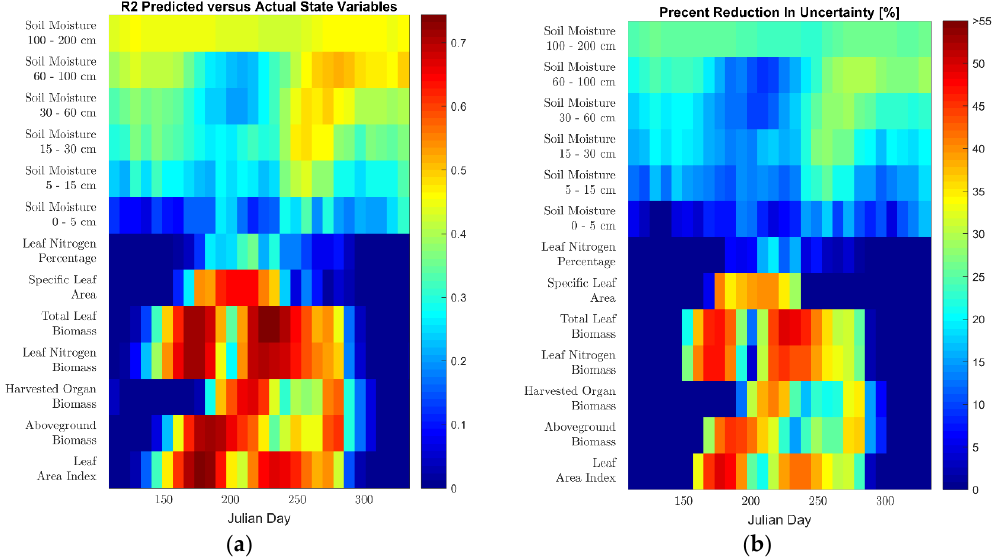
Figure 10. ( a ) CV R 2 and ( b ) CV PRU physical state variable prediction results in selected weather-based clusters.